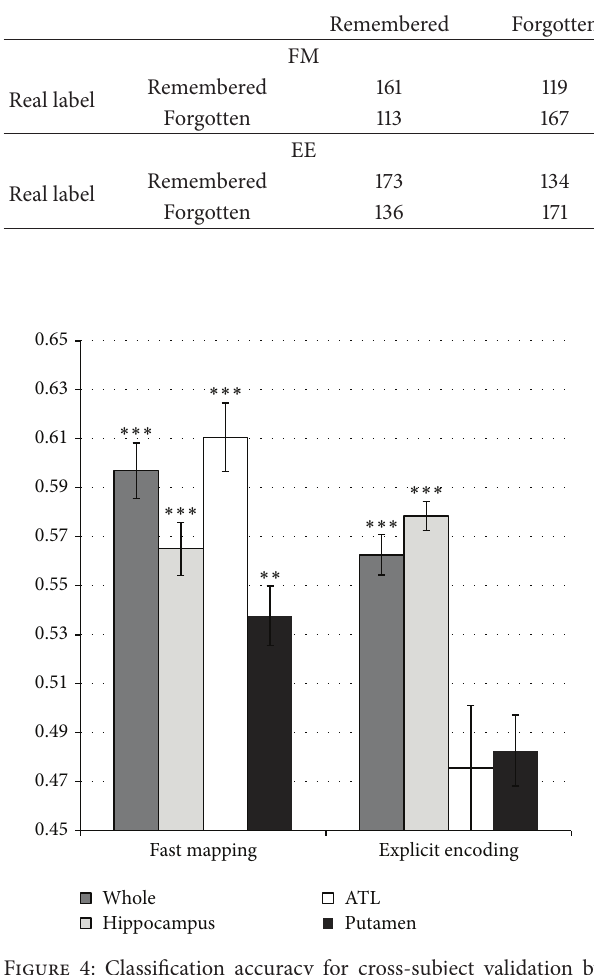
Figure 4: Classification accuracy for cross-subject validation by ROI. Error bars represent standard errors of the mean. ∗∗∗ 𝑃 < 0.001 ∗∗ 𝑃 < 0.01 , permutation